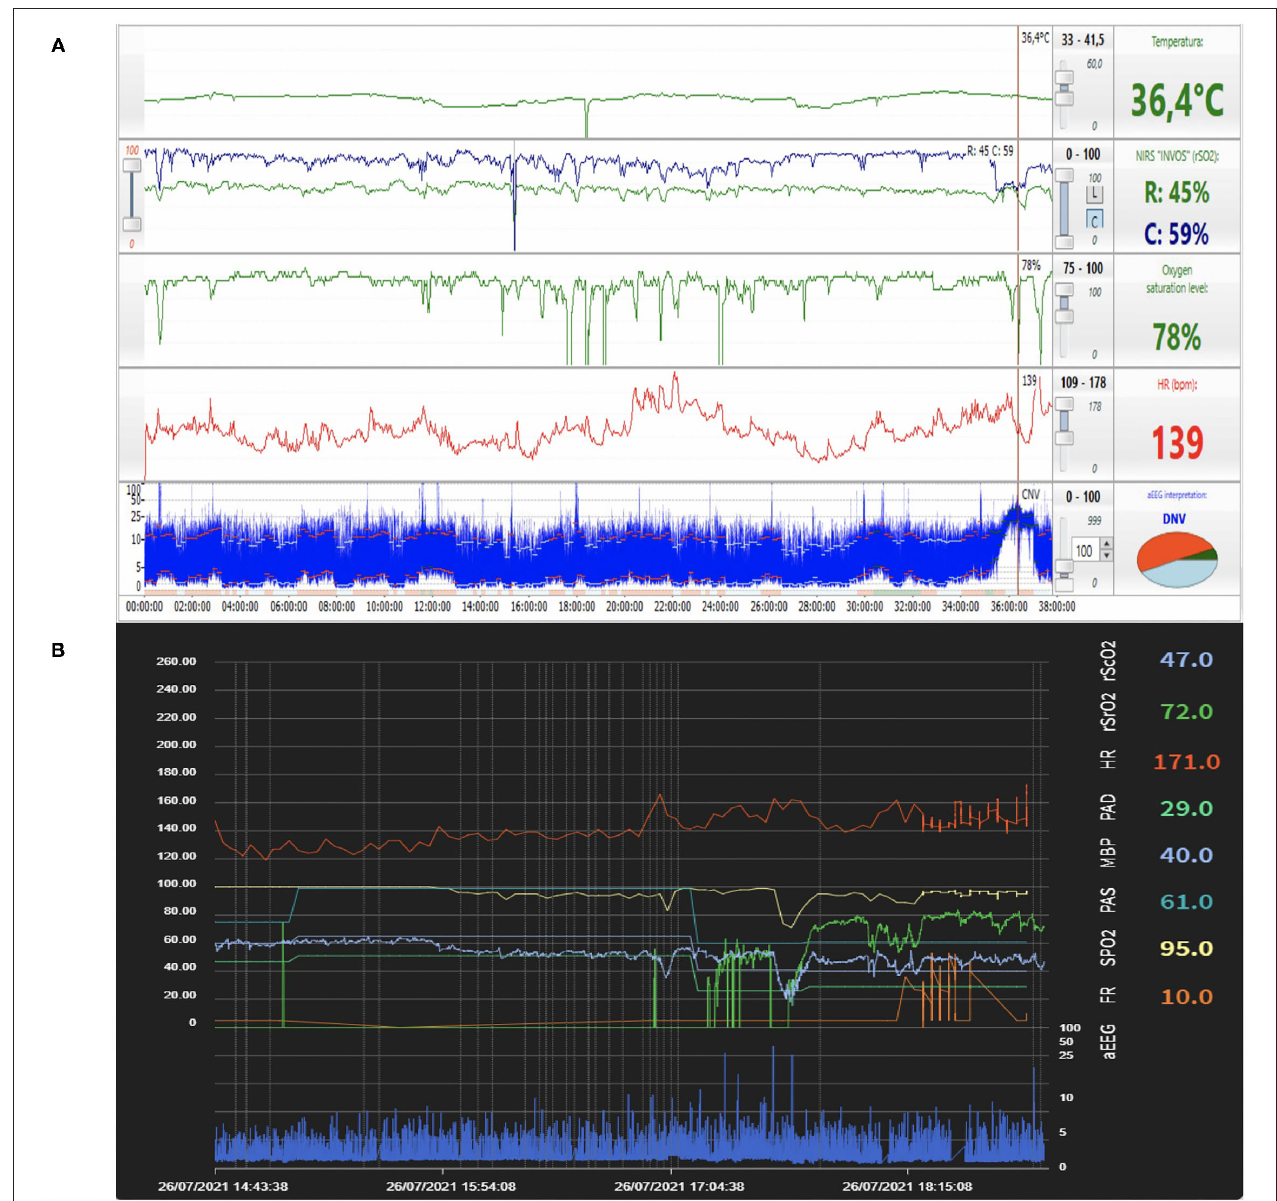
FIGURE 2 | (A) Example of a multimodal approach combining aEEG, NIRS, pulse oximetry, heart rate, and temperature findings in real-time. During the seizure episode noted on aEEG (arrow), a decrease in rScO 2 was observed together with significant fluctuations in pulse oximetry and heart rate. Figure from the authors’ personal file. (B) Example of a multimodal approach combining aEEG, NIRS, pulse oximetry, heart rate findings in real-time in proprietary software developed using a specific programming language (Python). Correlation between aEEG (continuous low voltage pattern) and low rScO 2 is observed. Figure from the authors’ personal